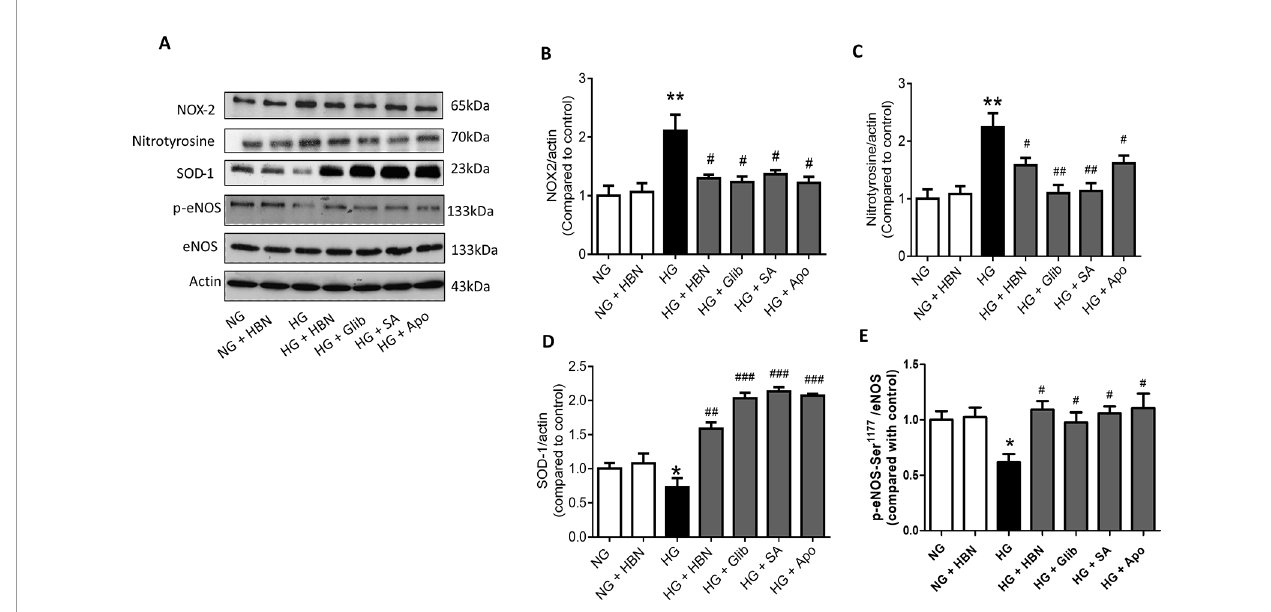
FIGURE 6 | Western blot and quantitative data showing proteins in HUVECs treated with normal glucose (NG, 5 mM), high glucose (HG, 30 mM), hydrolyzed bird nest (HBN, 30 m g/mL), sialic acid (SA, 20 m g/mL), glibenclamide (Glib, 10 m M), and apocynin (Apo, 20 m M) for 48 h. Results are means + SEM of four separate experiments. *P< 0.05 and **P < 0.01 compared to control; # P < 0.05, ## P < 0.01 and ### P < 0.001 compared to HG.